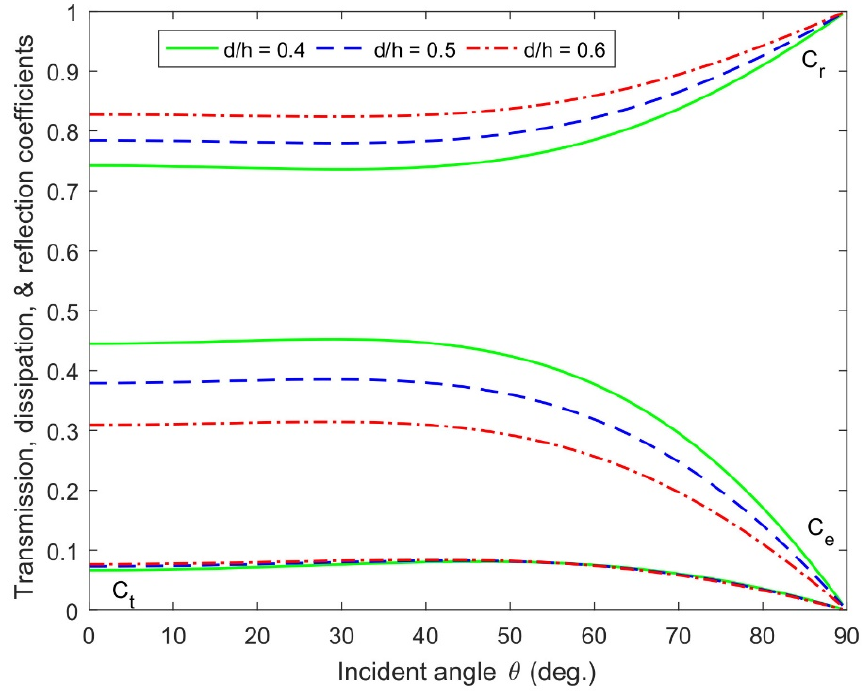
θ C C , and C . on , r t e